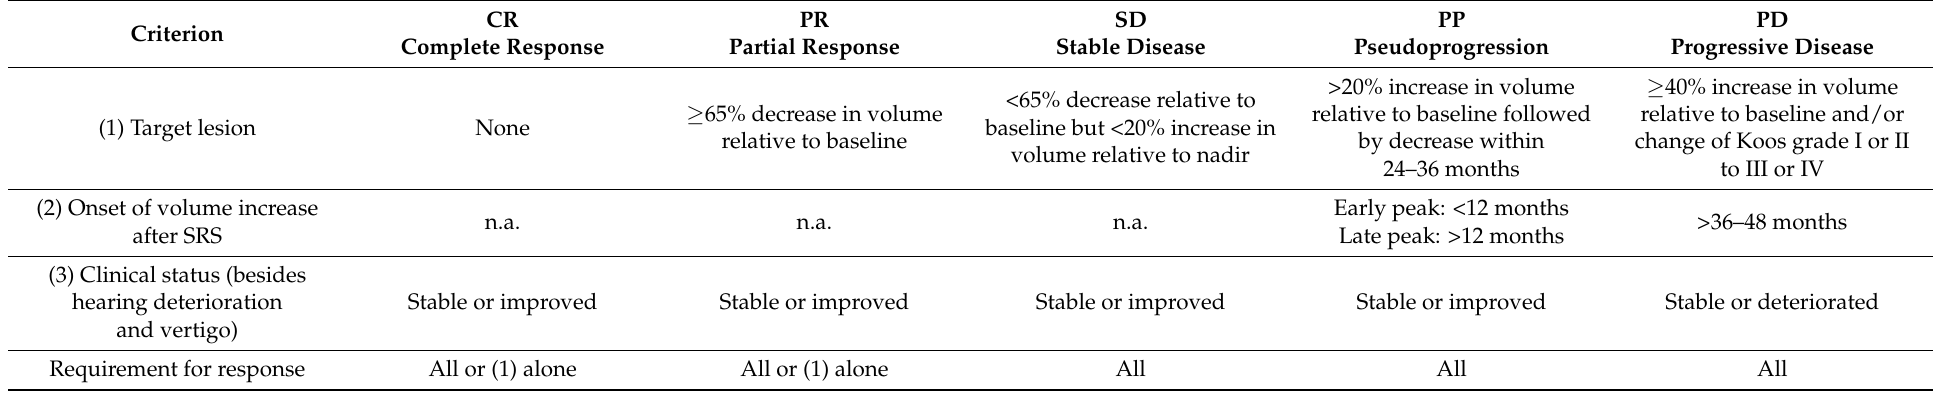
Table 1. Proposed RANO criteria for assessing tumor response after SRS of